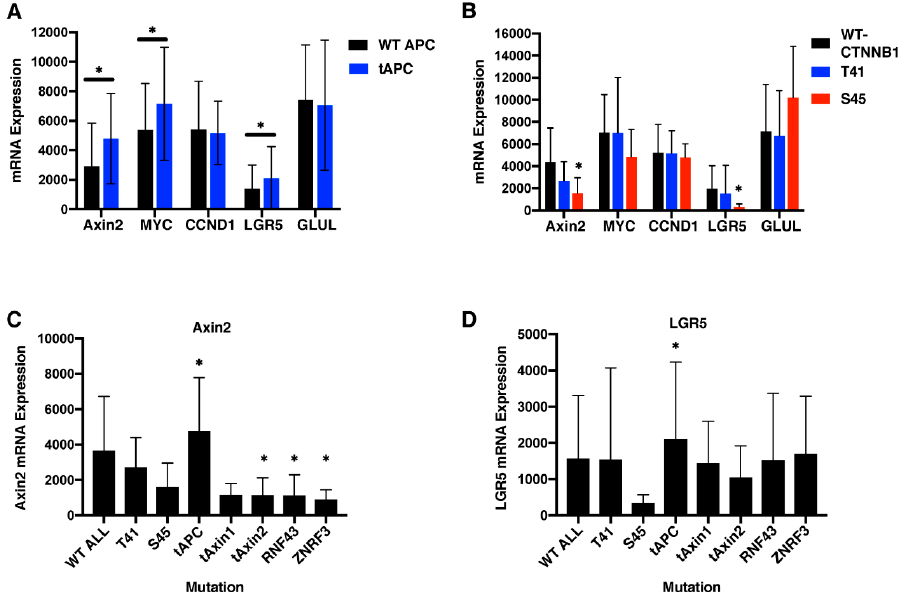
Figure 6. Wnt target gene activation in colorectal cancers with truncating APC mutations. Wnt target gene mRNA expression was determined from 524 colorectal cancer patients using cBioPortal and is displayed as RSEM. CCND1 encodes CyclinD1 and GLUL encodes Glutamate–Ammonia Ligase. ( A ) mRNA expression in 374 patients with truncating “driver” APC mutations and 150 with wild-type APC or missense mutations (all included in the wild-type category). ( B ) mRNA expression for 491 patients with wild-type CTNNB1 , 7 with Ser45 mutations, and 6 with Thr41 mutations. For ( C ) and ( D ) 426 colorectal cancer patient samples were queried for levels of Wnt target AXIN2 or LGR5 RNA, respectively. Samples were categorized by mutation status of CTNNB1 or truncating driver mutations in β -catenin regulatory genes. WT ALL samples had no driver mutations in any Wnt-related category queried. Error is presented as SD. * indicates p -value calculated with paired student T -test < 0.0005 in ( A ) and < 0.05 in ( B – D ) for each pair combination. For ( C ) and ( D ), n values of each group were